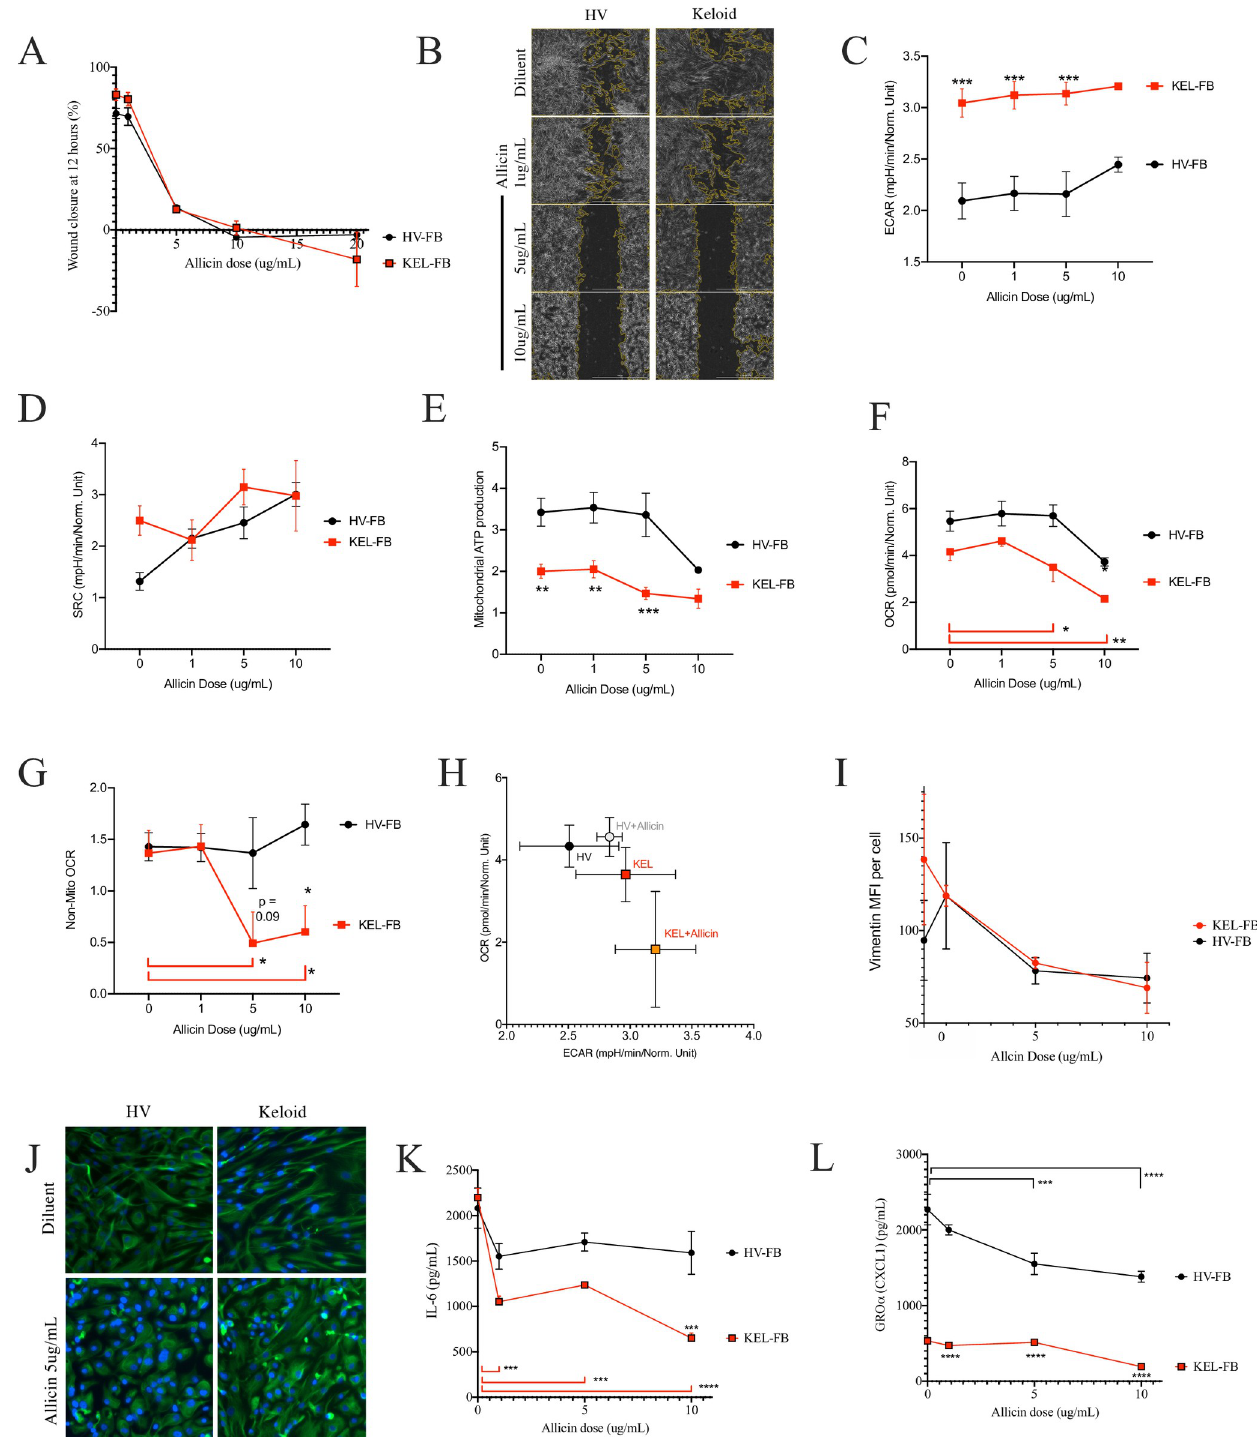
Fig 5. Allicin impacts scratch outcomes and metabolic function. (A-B) Wound closure as 12 hours (A) and representative image (B) for keloid (KEL-)or health volunteer (HV-) fibroblast cell lines (FB) after treatment with indicated doses of allicin. (C-F) Seahorse assay results for extracellular acidification rate (ECAR; C), spare respiratory capacity (SRC; D), mitochondrial (mito) ATP production (E), basal oxygen consumption rate (OCR; F), non-mitochondrial OCR (G), and ratio of basal ECAR to OCR (H) are shown. (I-H) Mean fluorescence intensity (MFI) per cell (I) and representative images (H) for vimentin for HV-FB and KEL-FB treated with indicated doses of allicin. (K-L) Supernatant accumulation of interleukin (IL-) 6 (K) and CXCL1 (L). Results are